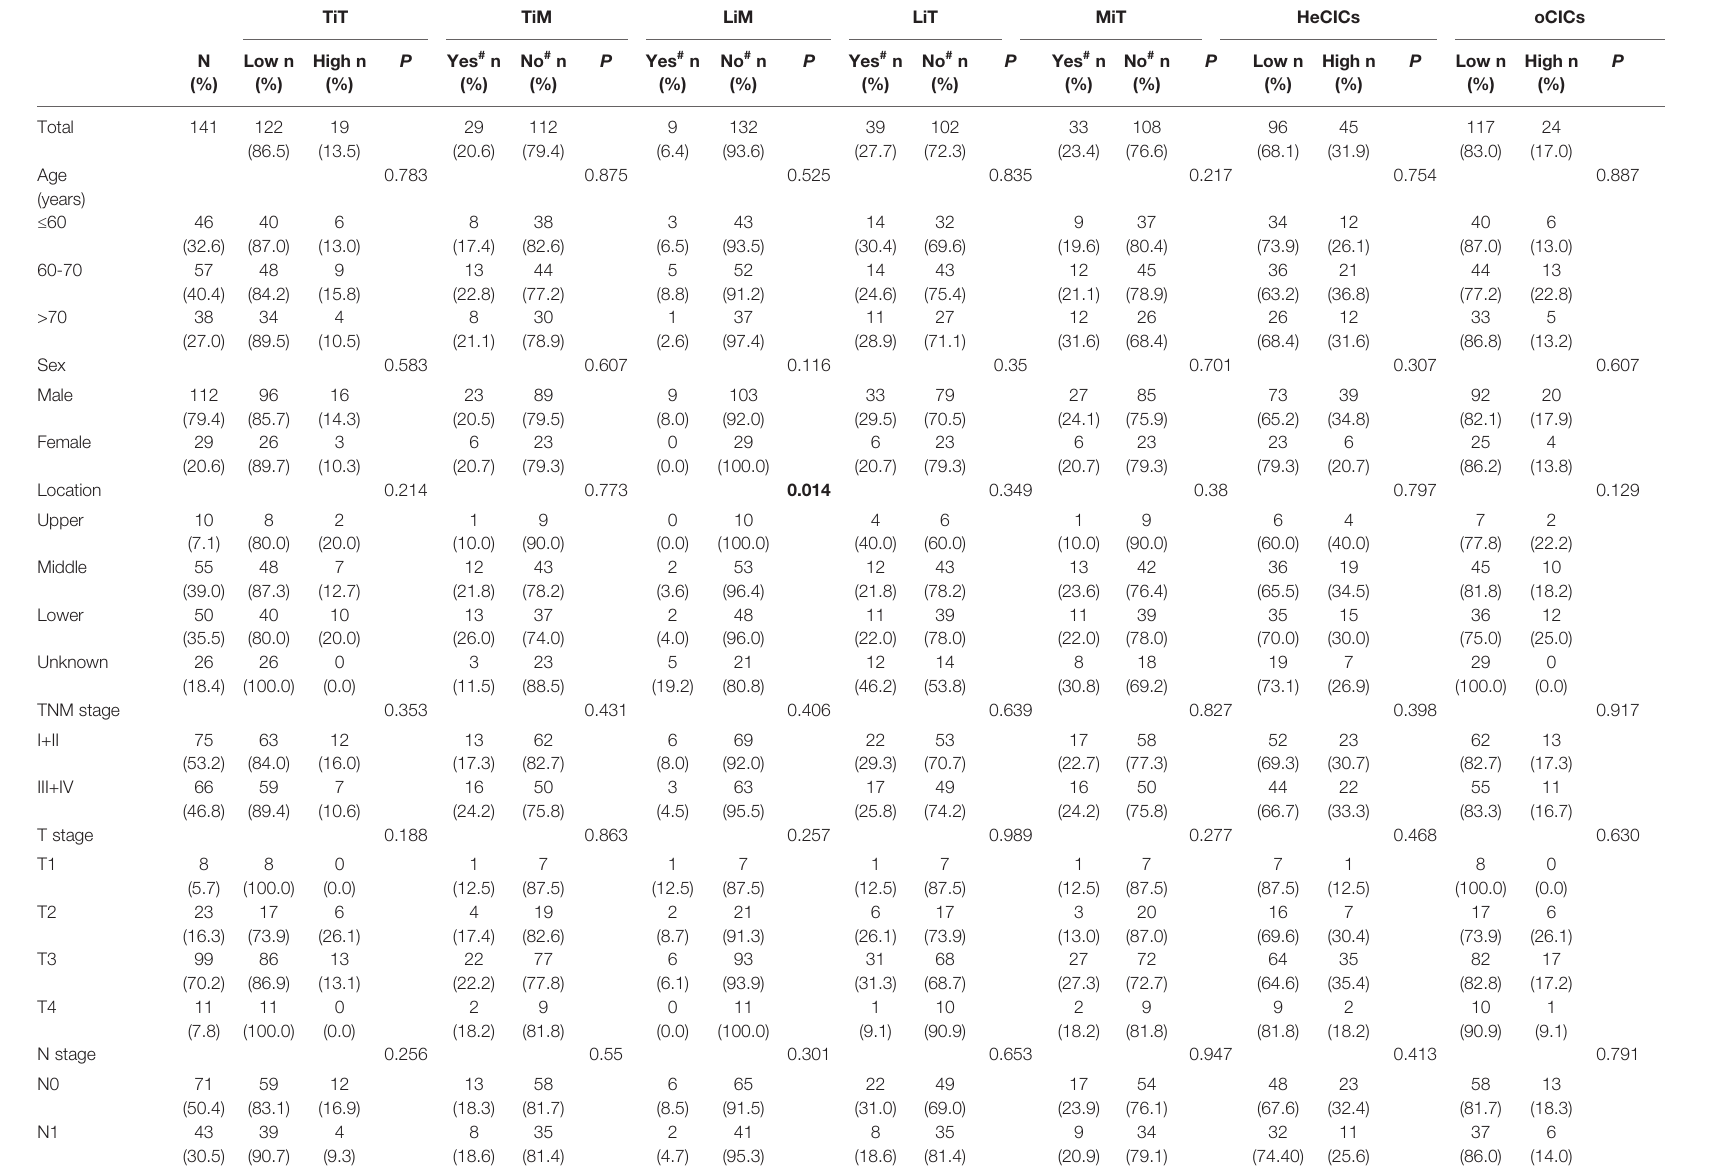
TABLE 1 | Association of CIC subtypes with clinical pathological